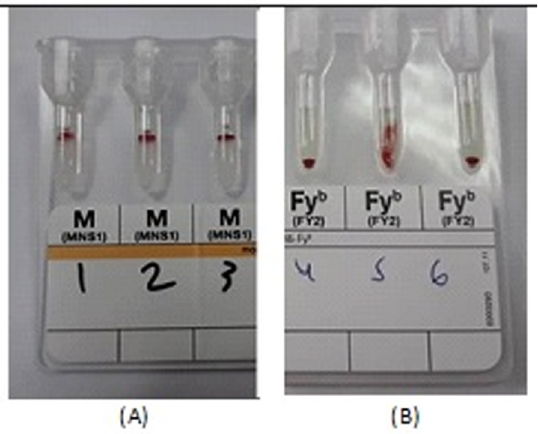
Fig 2. Phenotyping of Non-ABO erythrocyte antigens performed on ID-card “DiaClon Anti-M (A) revealed positive results in patients no. 1,2,3 and another one on ID-card “DiaClon Anti-Fy b ” (B) revealed negative results in patients 4 &6 and positive in